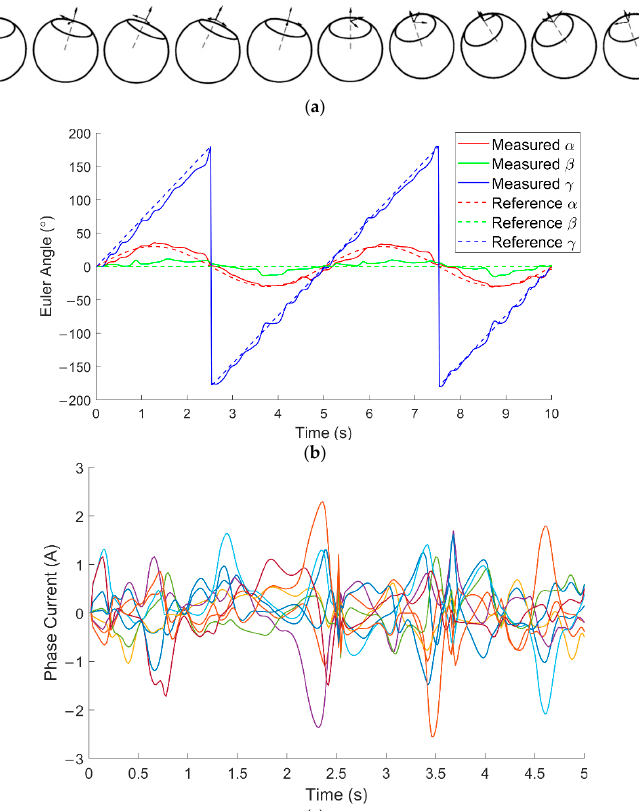
Figure 15. Experimental closed-loop results: ( a ) Geometric visualization of the rotor reference trajectory; ( b ) Time responses for reference tracking in α , β and γ angles; ( c ) Corresponding phase currents. While the average absolute tracking error is low for b, periodic spikes in the error are present, predominantly with respect to the γ angle.